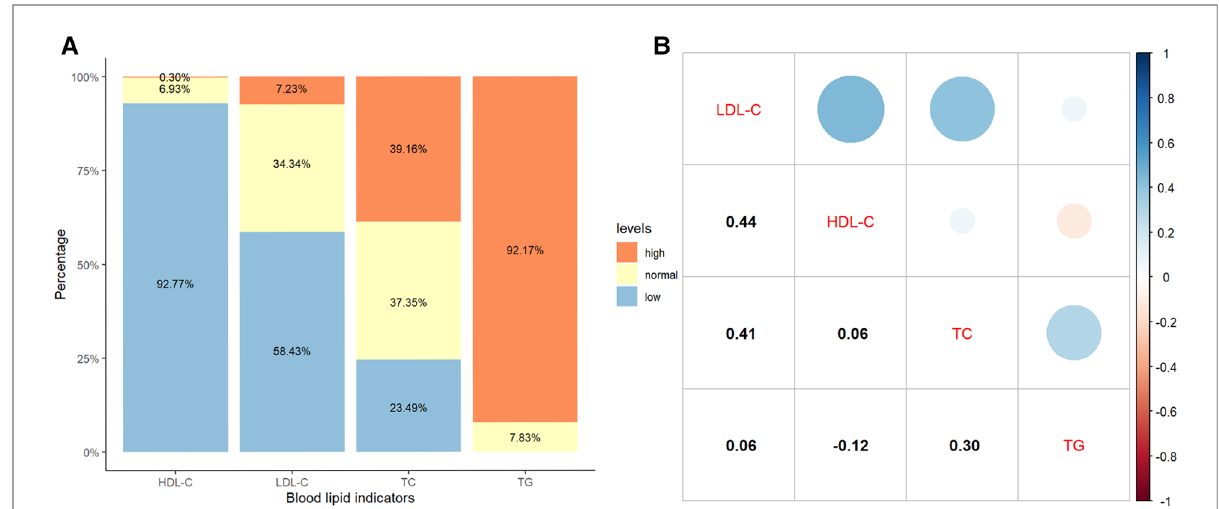
FIGURE 2 Distribution and correlation of blood lipid indicators in 349 patients. ( A ) Percentage bar-chart of blood lipid indicators; ( B ) Pearson correlations between blood lipid indicators. Note: Normal thresholds for TG, TC, HDL-C and LDL-C are de fi ned as <1.80 mmol/L, 3.11 – 5.18 mmol/L, 1.04 –